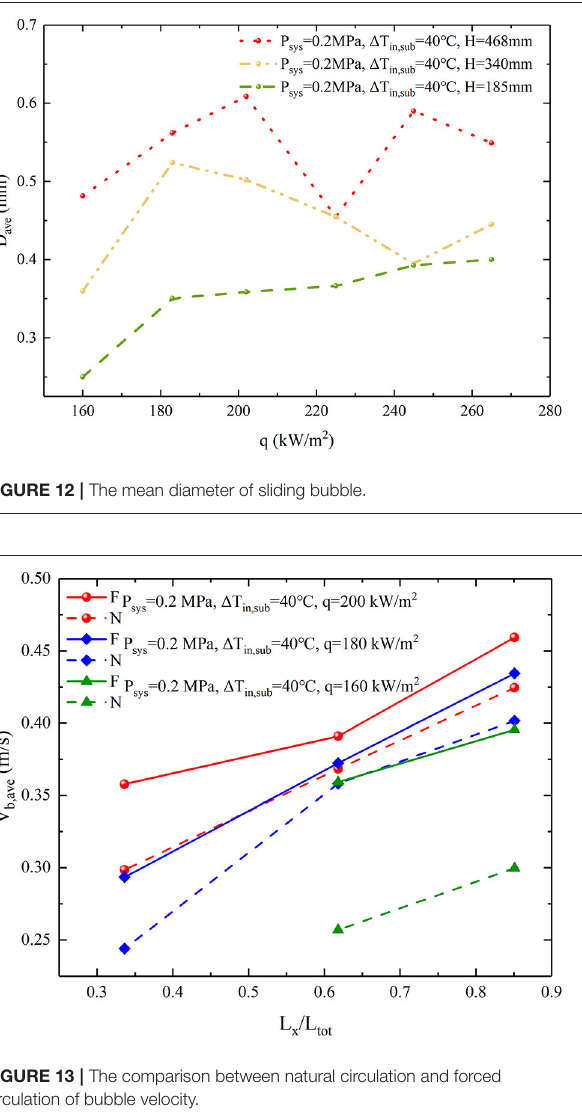
other reason is the heat flux ( < 200 kW/m 2 ) will make the bubble diameters larger, and the increased bubble diameter can result in a larger drag force acting on the bubble, which can cause an acceleration of bubble